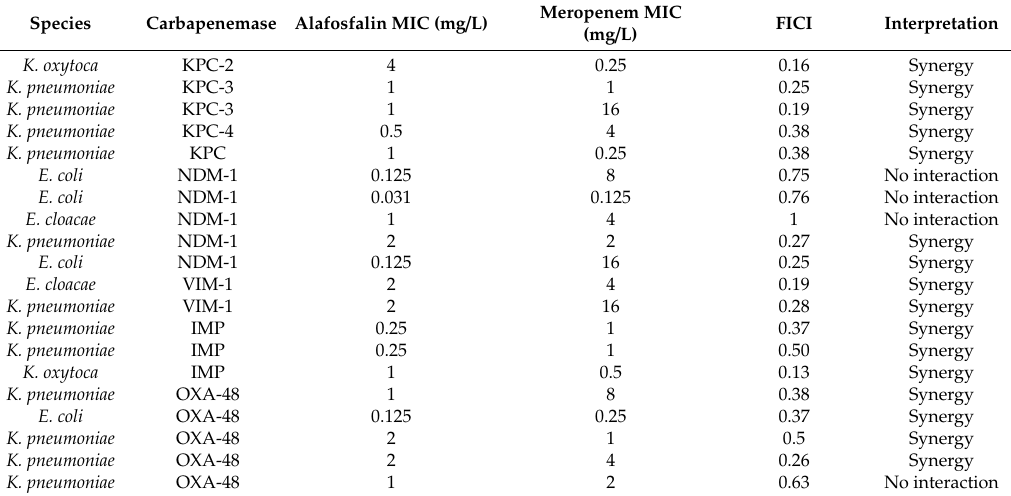
Abbreviation: FICI; Fractional inhibitory concentration